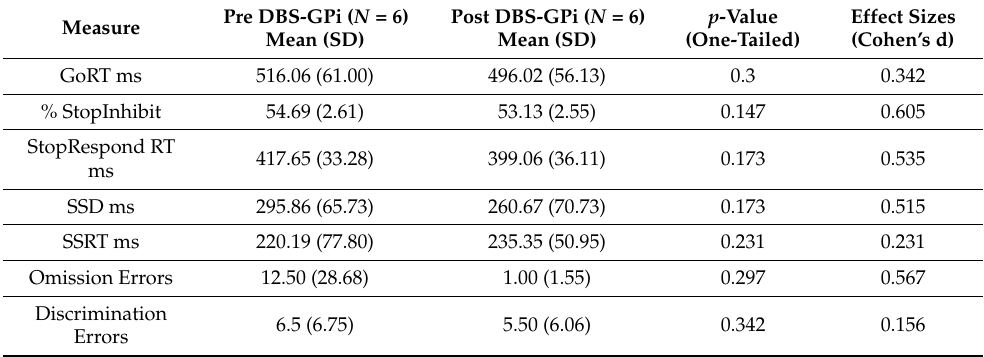
Table 3. Means and standard deviations (in parentheses) of the measures on the stop signal task for patients with Tourette Syndrome (TS) pre-DBS surgery and post-DBS surgery. RT = reaction time, SSD = stop signal delay, SSRT = stop signal reaction